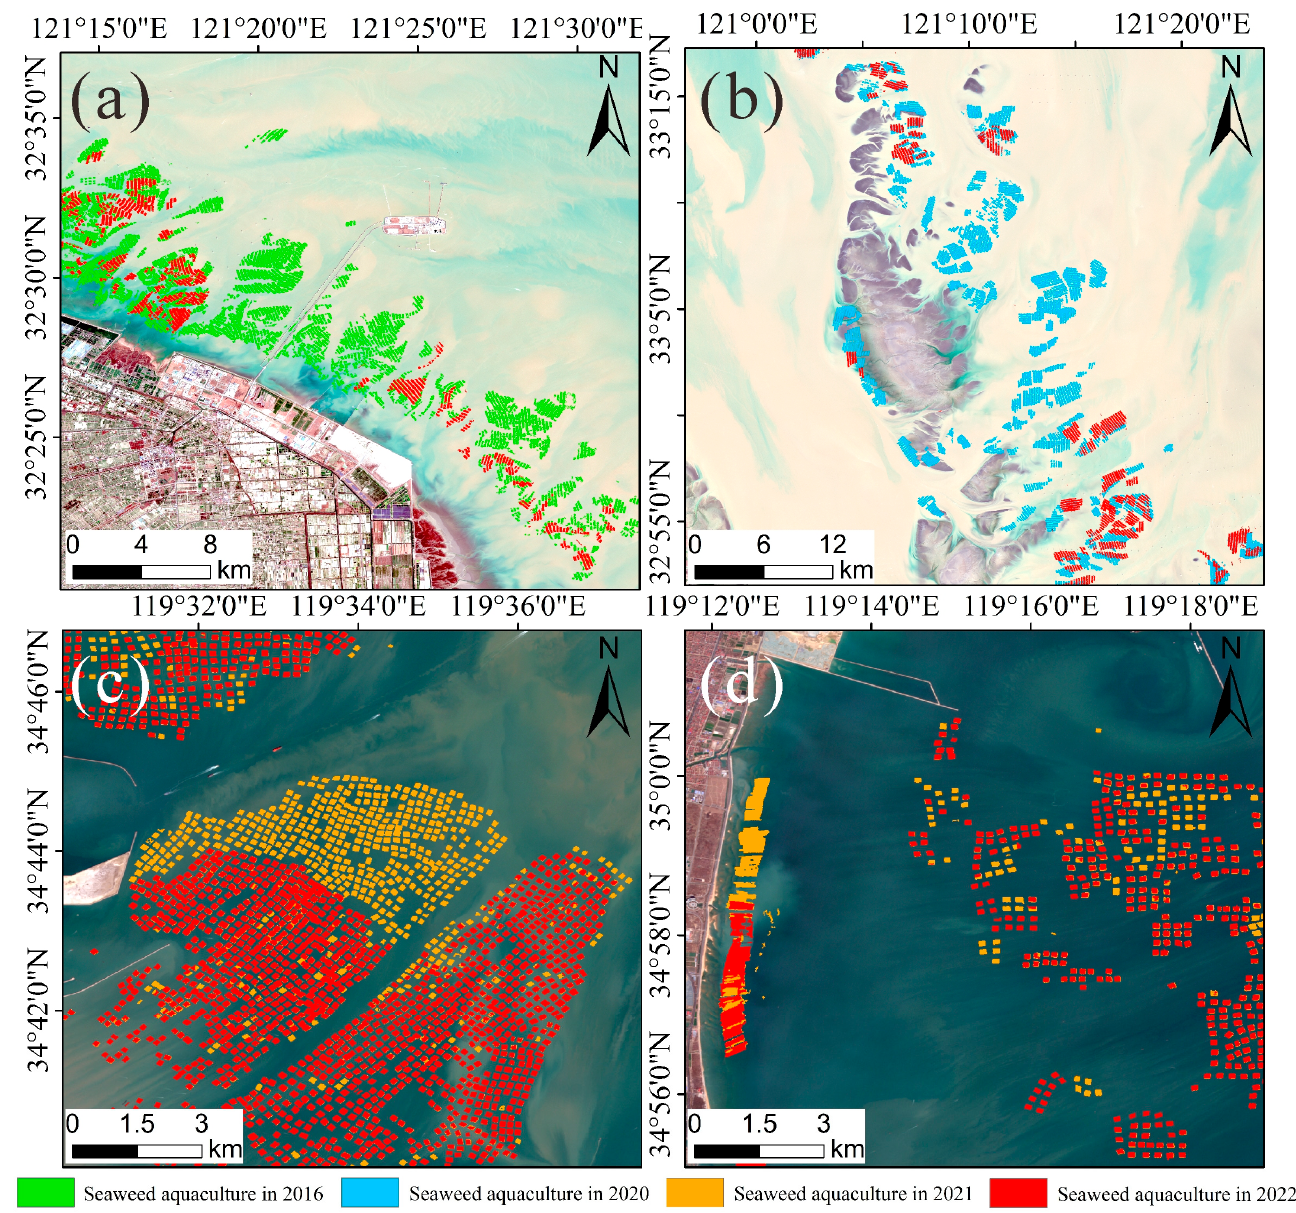
Figure 7. Spatial performance of policy restrictions (the reduction of the breeding scale of Mode-II is in the Yangkou Port waterway ( a ) and the east of the nature reserve ( b ); Mode-I’s reduction in breeding scale ( c ) and breeding density ( d )).